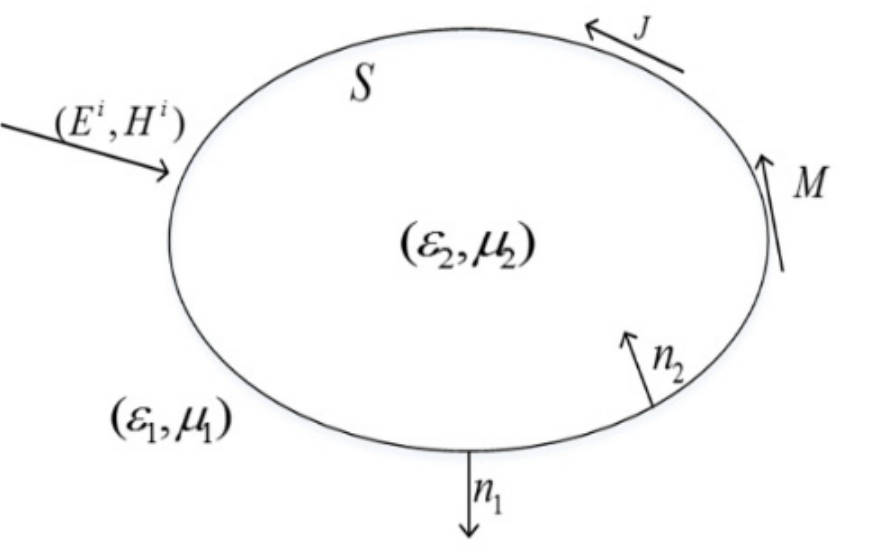
Figure 1. Light scattering from a plasmonic metal object.